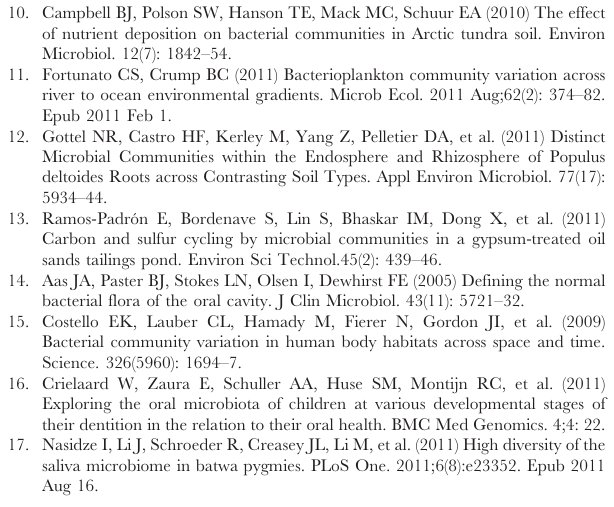
Figure S1 Idealized rank abundance curve with com- mon and rare taxa labelled. The common taxa have been